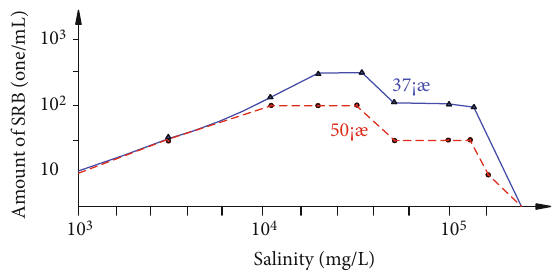
Figure 3: The e ff ect of di ff erent salinity on the growth of